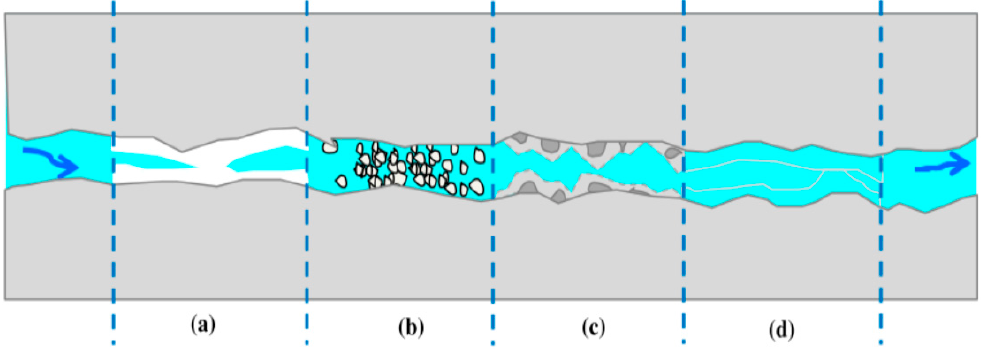
Figure 2. Main mechanisms of autogenous healing [37].